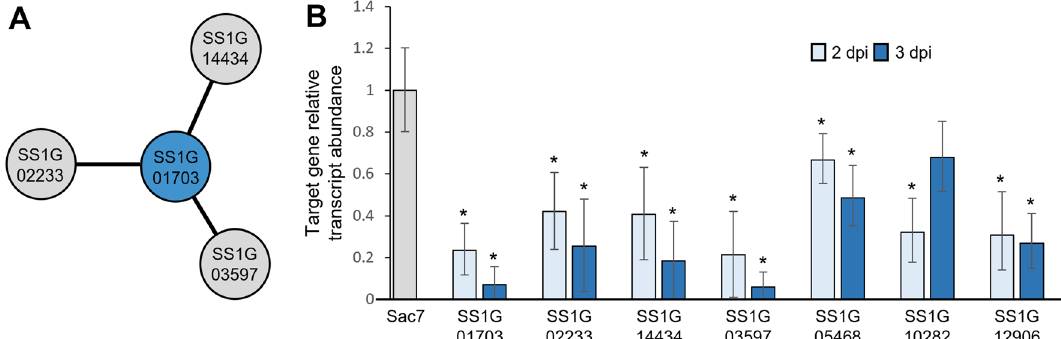
Figure 5. Transcript abundance of ABHYDROLASE-3 (SS1G_01703) predicted interacting partners using RT-qPCR. ( A ) predictive interacting network of ABHYDROLASE-3 generated through Stringdb based on gene fusion and co-expression analyses. ( B ) RT-qPCR target transcript abundance of predicted interacting partners in S. sclerotiorum challenging AT1703 A. thaliana at 2- and 3-days post inoculation relative to wild-type Col- 0 . Target transcript abundance calculated using the ∆∆CT method with Sac7 as a reference gene. Each line consists of three biological replicates, each containing three infected A. thaliana leaves. Error bars represent standard error and significance was determined using a Student’s t -test (p < 0.05) with a Bonferroni correction.